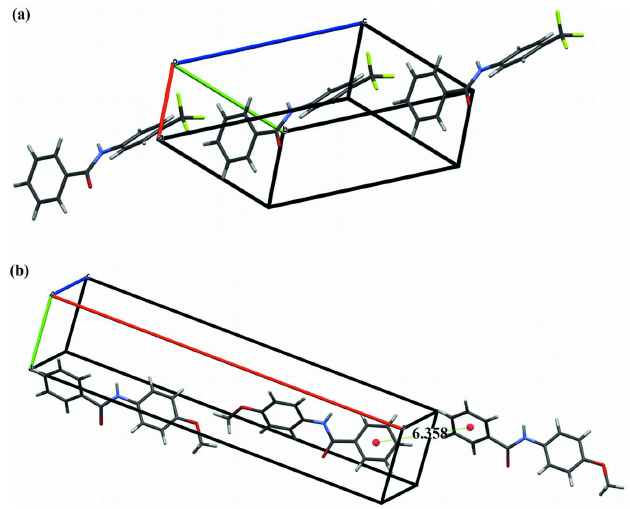
Figure 7 View of contacts (in A˚ ) along the molecular axes in ( a ) TFMP and ( b ) MOP